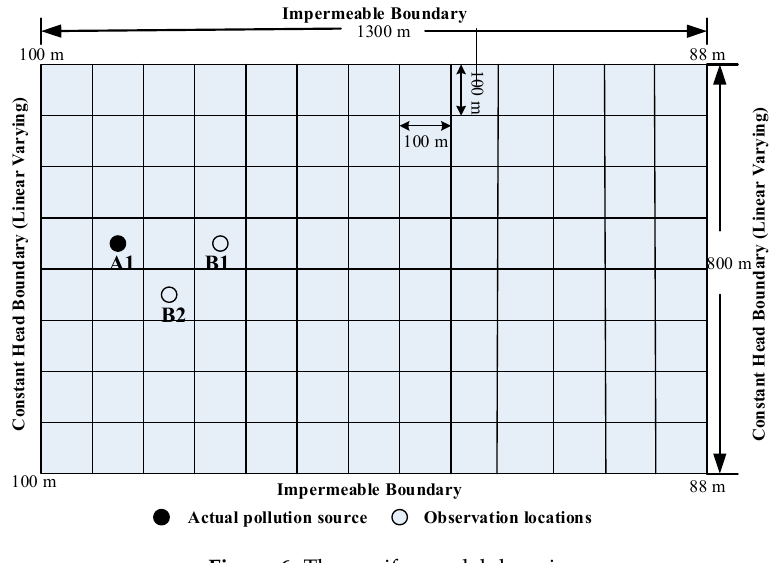
Figure 6. The aquifer model domain.